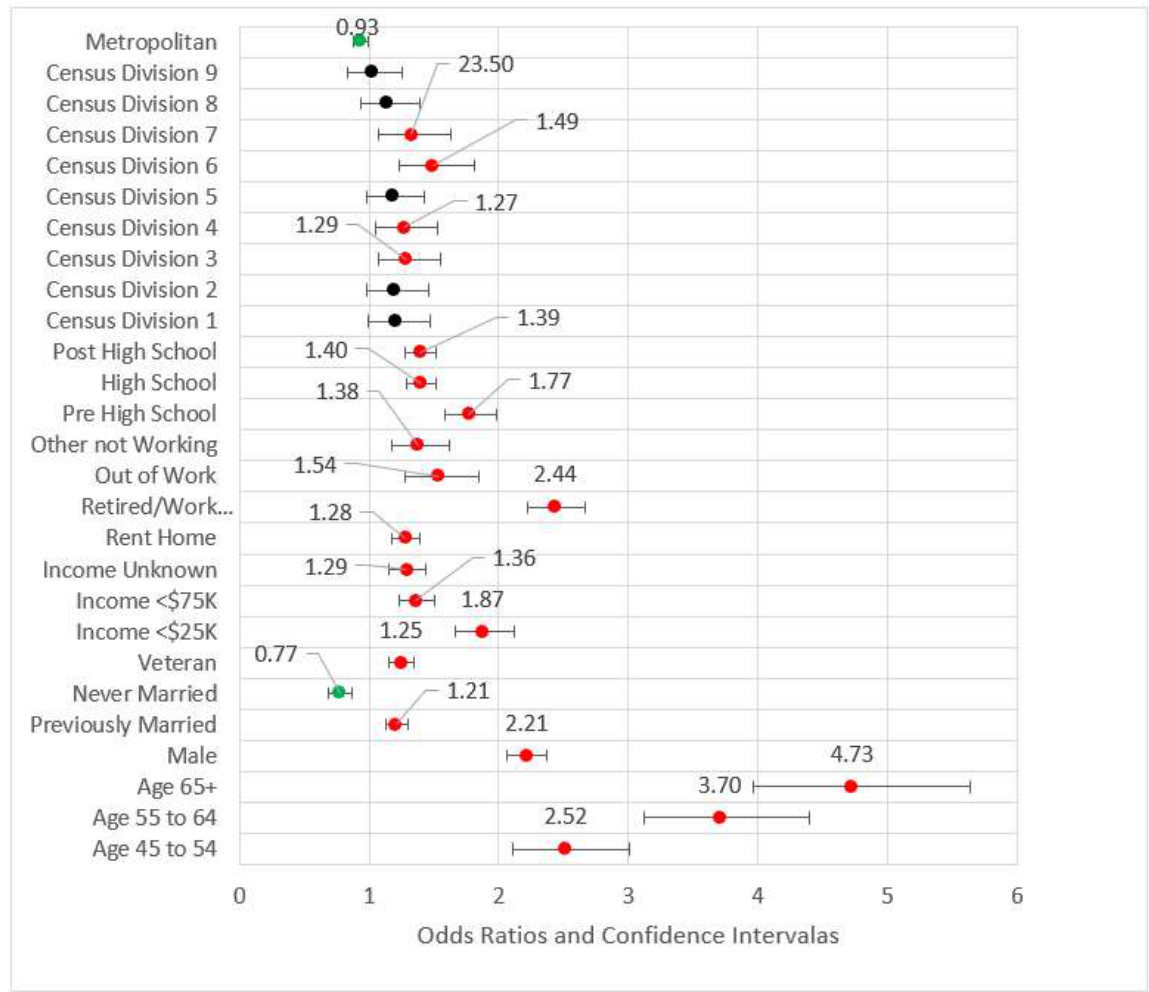
Figure 3. Forest plot of Model 3 (red = significant odds ratios greater than 1.0, green = significant odds ratios less than 1.0, black = not significant) .